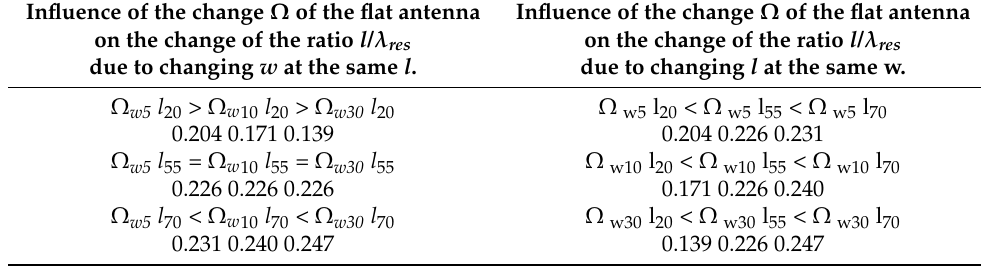
Influence of the change Ω of the flat antenna